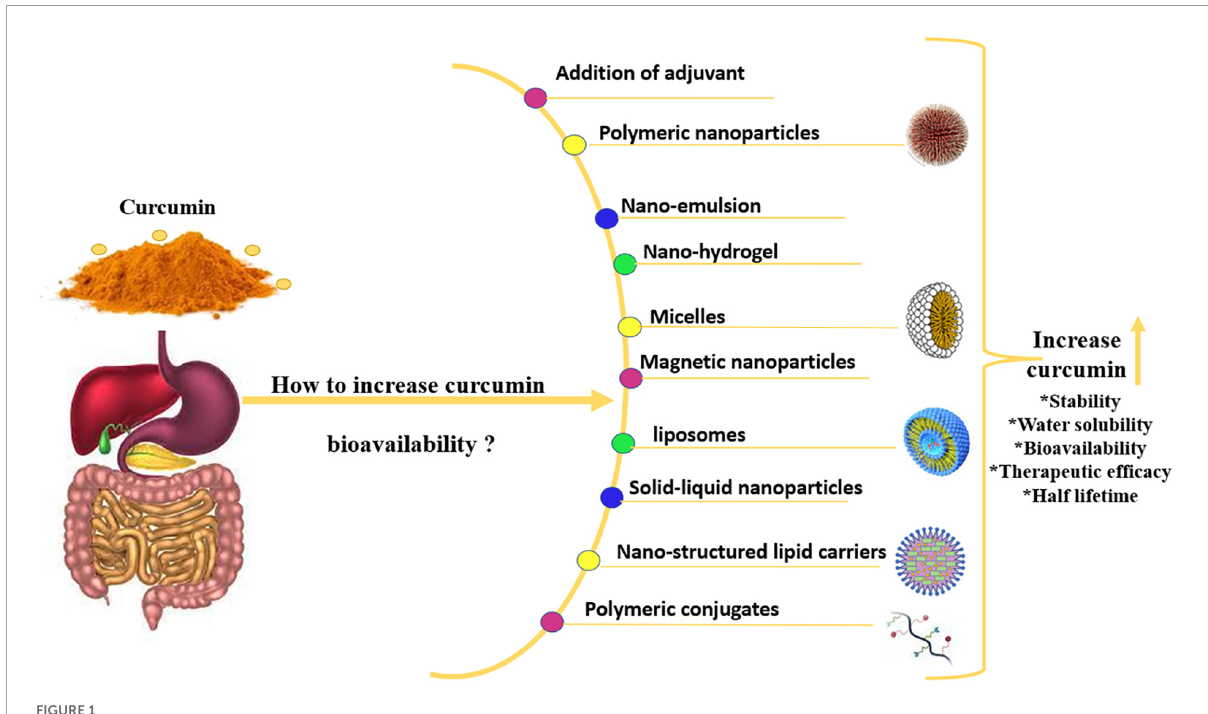
FIGURE1 Novel methods to increase curcumin